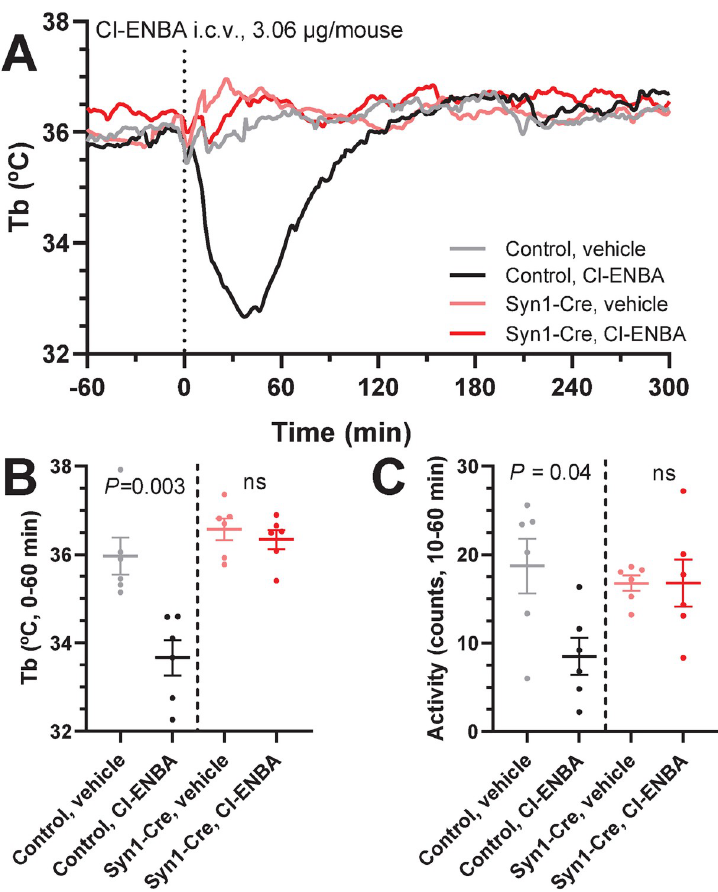
Fig 4. Central administration of Cl-ENBA does not cause hypothermia in Adora1 fl ;Syn1-Cre mice. (A-C) Tb and physical activity response to Cl-ENBA (3.06 μ g/mouse, i.c.v.) or vehicle in Adora1 fl (control, n = 6) and Adora1 fl ; Syn1-Cre (Syn1-Cre, n = 6) mice. Data are mean ± SEM (SEM is omitted for visual clarity in A). P values were calculated by paired t -test comparing drug vs vehicle within mouse.